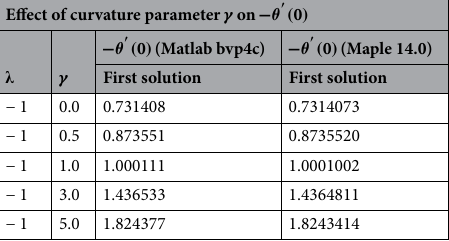
′ ( 0 ) Table 1. Effect of curvature parameter γ on − θ . ′ ( 0 ) Comparison of f for (cid:31) = 0 Chamkha and Khaled 66 For B = ′ ( 0 ) Table 2. Comparison of f when (cid:31) = 0 . Here we have N 1 = 0, N 2 = 0, m = 0, γ = 0, ω = 0, Lb = 0, Le = 0, Pe = 0, A = 0.